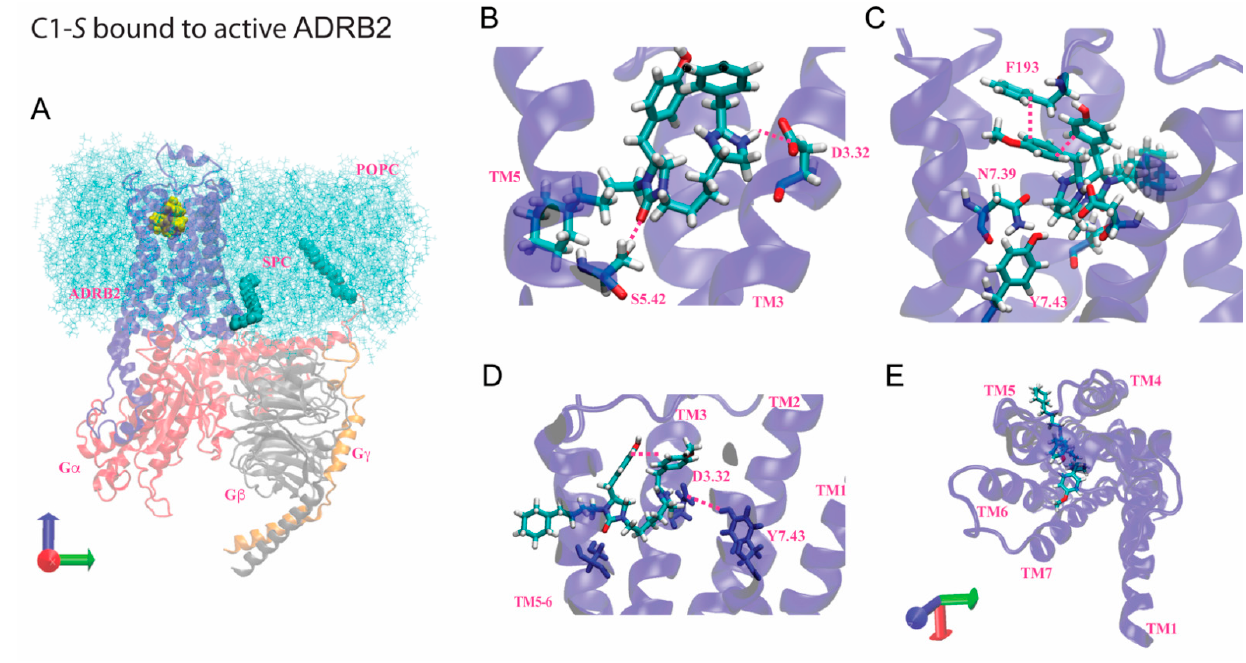
Figure 6. Predicted site for C1-S binding to β 2AR coupled to Gs. ( A ) Orientation of C1-S (yellow) bound to the activated receptor (blue) in explicit membrane (light blue) and water. The G protein subunits are indicated in red (G α s), grey (G β ) and gold (G γ ). ( B , C ) Selected views of the interactions of C1-S with activated β 2 AR, including the imidazole interaction with Asp113 3.32 (salt bridge) and Asn312 7.39 (hydrogen bond), the urea interaction with Ser203 5.42 (hydrogen bond), and π – π stacking of both aromatic rings of the agonist to each other and to Phe193 ECL2 . ( D ) The intrareceptor bond between Asp113 3.32 and Tyr316 7.43 . ( E ) The TMD pocket as viewed from the extracellular side. POPC, phosphatidylcholine; SPC, palmitoylated region of the receptor and G α s, which attaches to the membrane. See Figure 7 for the pharmacophores.